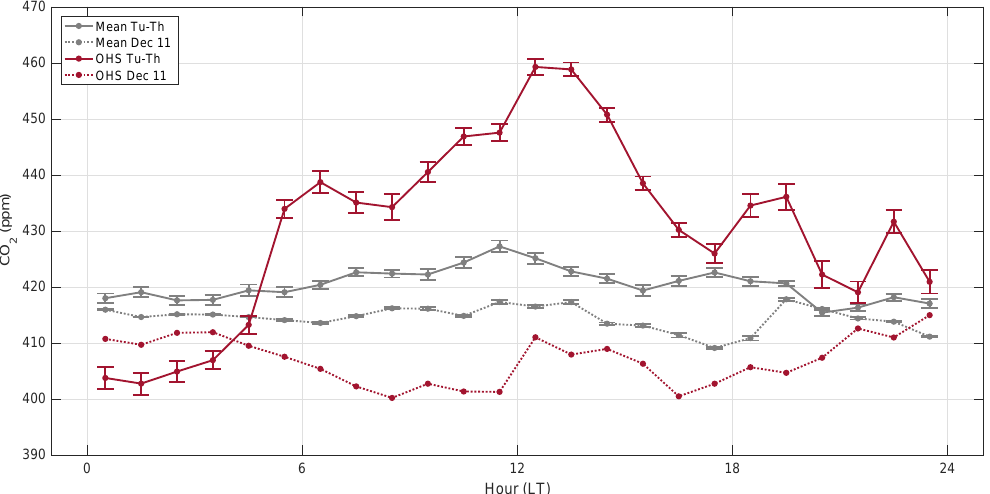
Figure 12. Comparison of diurnal variation in drift- and bias-corrected CO 2 dry air mole fractions observed at Oakland High School (OHS in Fig. 1) during a rain-related school closure on 11 December 2014 vs. the mean variation observed on other Tuesdays, Wednesdays, and Thursdays during December 2014 when the school was operating normally. Mean values from five other BEACO 2 N sites operational during these time periods are also shown for reference. Error bars indicate standard error (instrument error is negligible at this